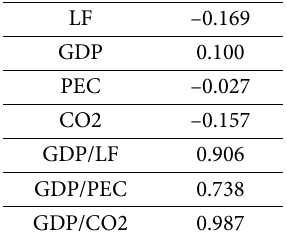
Table 5. Correlation